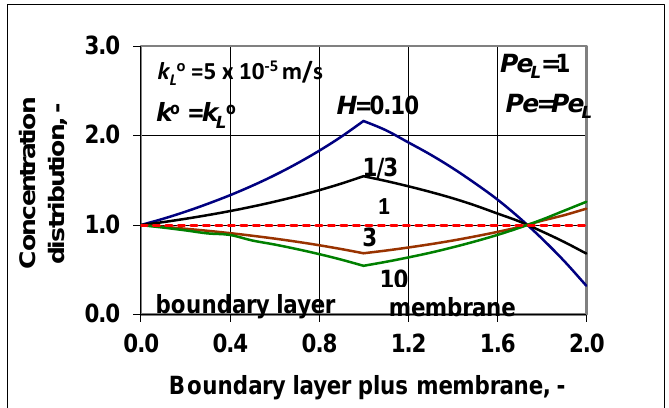
Figure 7. Polarization modulus as a function of the membrane Peclet number, calculated by Equation (36), at different values of the solubility coefficient, H . Values of the mass transfer coefficient and of the L P e of the polarization layer are the same as in Figure 6, namely ( = / oo LL P e P e kk ; o L k = 5 × 10 −5 m/s; = 0.1 o o L k k ).